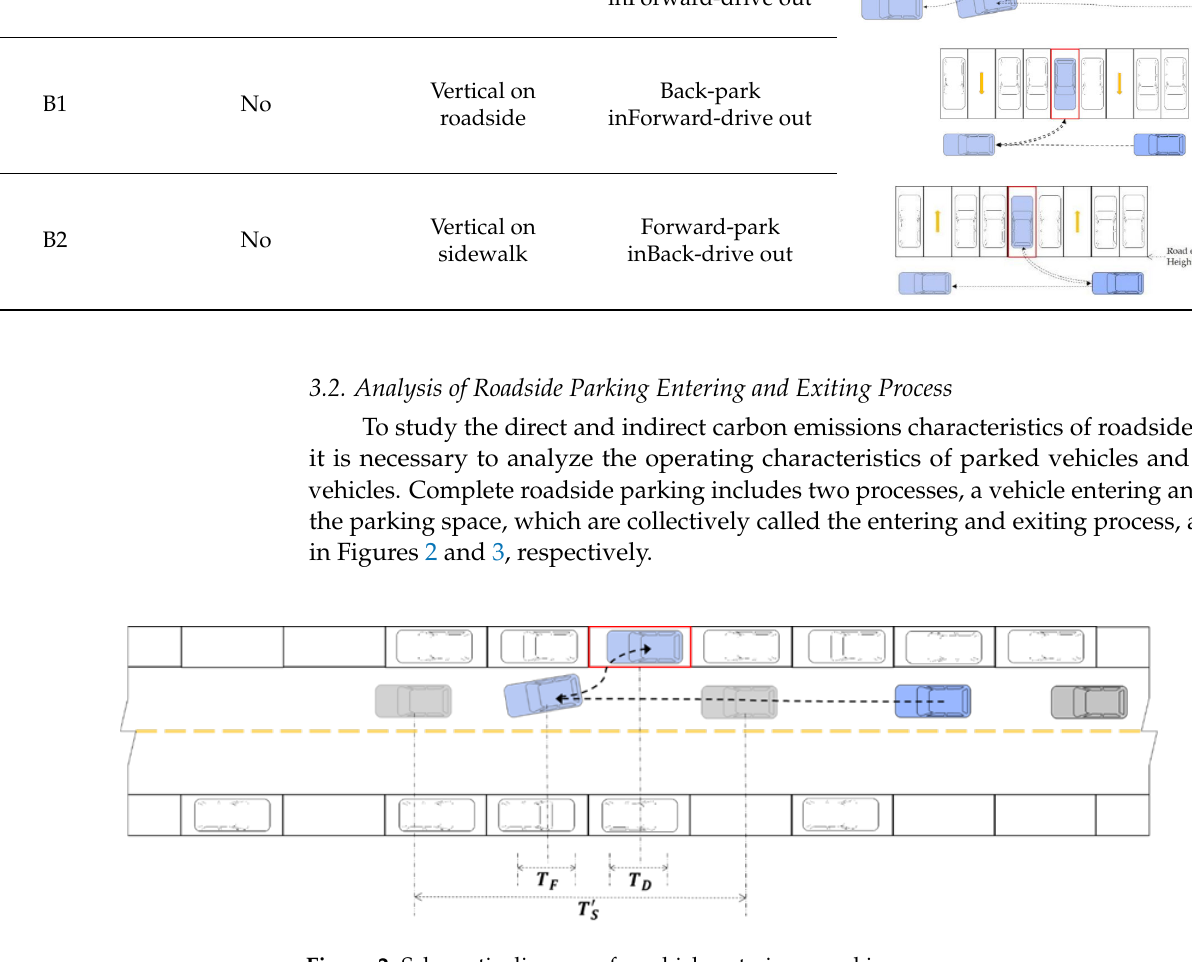
Figure 2. Schematic diagram of a vehicle entering a parking space.